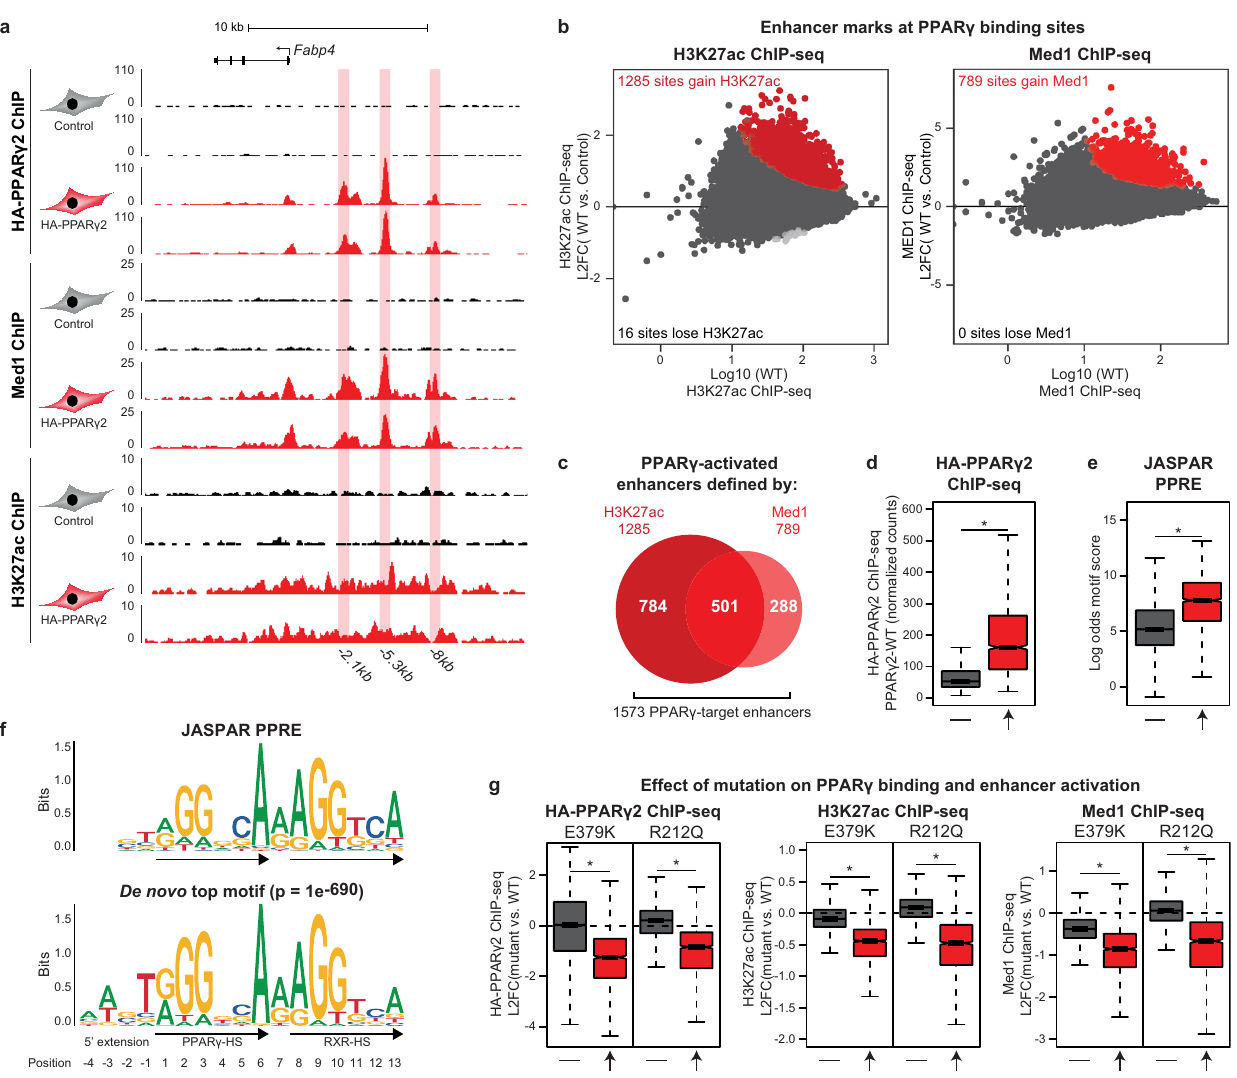
Fig. 6 | A subset of PPAR γ -bound sites are functional PPAR γ -target enhancers. a UCSCGenomeBrowserscreenshotshowingHA-PPAR γ ,Med1,andH3K27acChIP- seq in control and PPAR γ 2-WT expressing cells at the Fabp4 -locus. PPAR γ -binding sites (identi fi ed using Homer fi ndPeaks and extended to 500bp and passing a cutoffof<35tags)arehighlighted.AnnotationofPPAR γ -bindingsitesarerelativeto the transcriptionalstartsite (TSS)of Fabp4 . b Identi fi cationofenhancersactivated by PPAR γ 2-WT. H3K27ac and Med1 ChIP-seq signal was counted within 41830 PPAR γ binding sites extended ±1500bp (H3K27ac) or ±250bp (Med1) from peak center. Red and light gray points indicate enhancers that gain or lose ChIP-seq signal, respectively, upon PPAR γ 2-WT expression. Signi fi cance was determined by DESeq2withBenjamini – Hochbergcorrection,two-sidedtest(FDR<0.1).L2FC,log2 fold change. c Venn diagram showing the number of activated enhancers de fi ned by gain in H3K27ac and/or Med1 ChIP-seq signal, in total identifying 1573 PPAR γ - target enhancers. d Boxplot of PPAR γ ChIP-seq signal in enhancers that does not